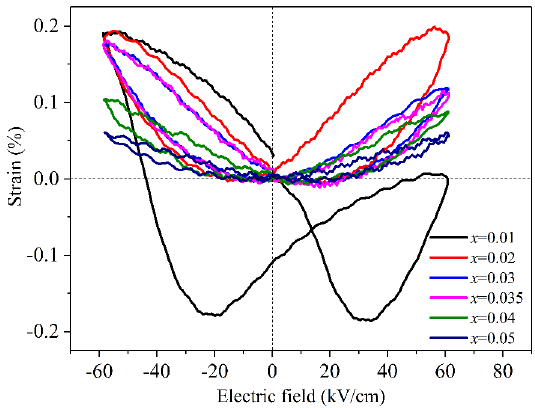
Figure 6. S-E loops of BNBT- x NT